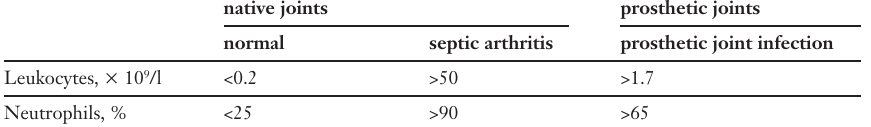
Characteristics of synovial fluid in patients with native and prosthetic